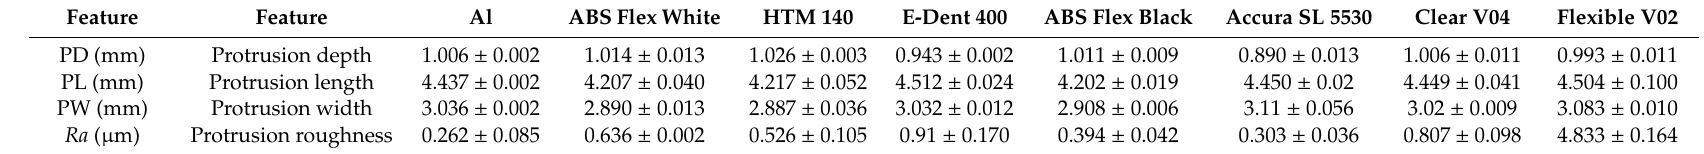
Table 3. Dimensional and surface metrology of prismatic protrusions.